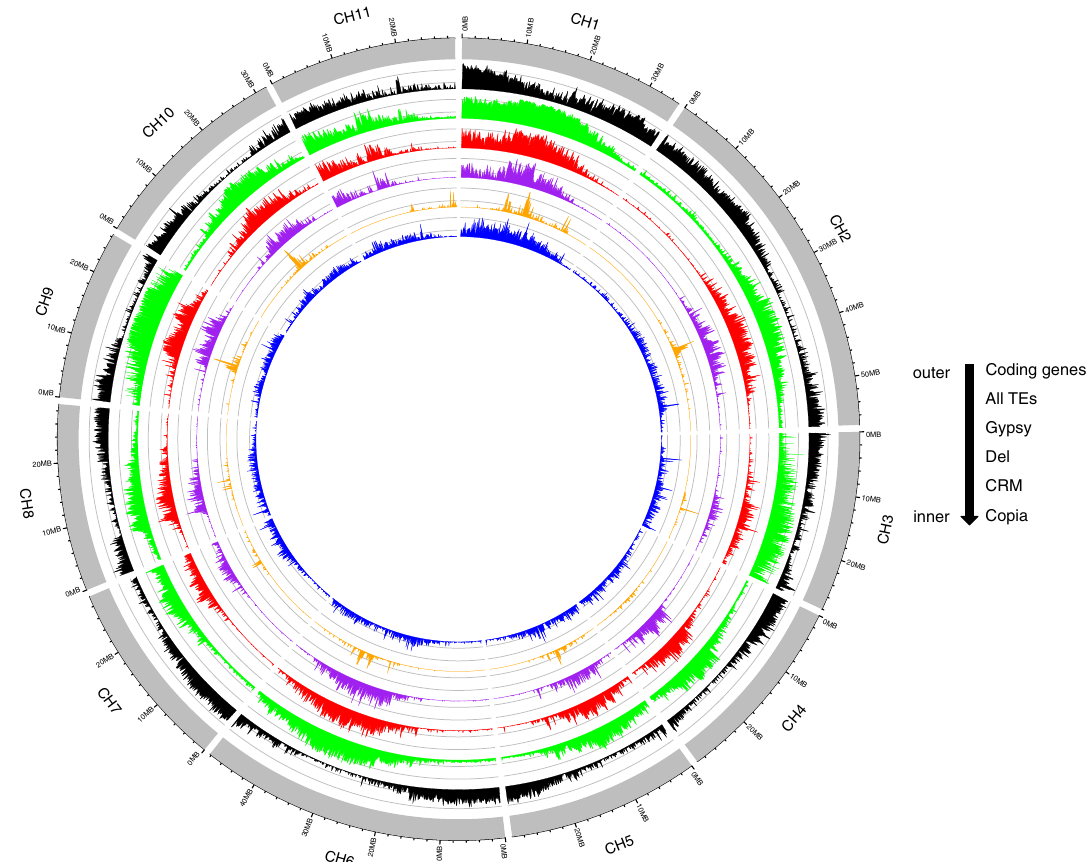
Figure 2. Features of the C. humblotiana genome. The density of the following features (predicted genes in black; all predicted transposable elements—TE—in green, Gypsy LTR retrotransposons in red; Del lineage, CRM lineage in orange and Copia LTR retrotransposons in blue) were calculated with a window’s length of 100 kb. Pseudochromosomes are oriented in a similar way to C. canephora available genome 15